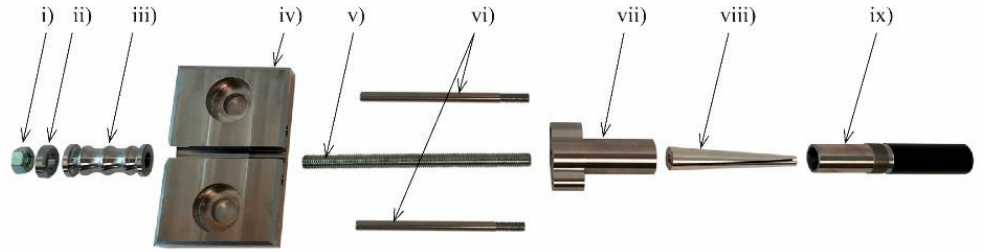
Figure 6. Anchor system parts. Table 1. Material properties of the anchor system.